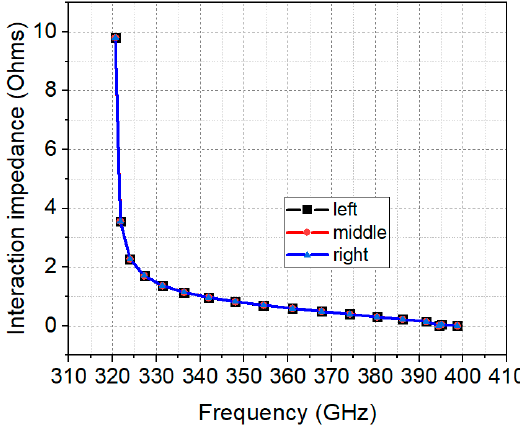
Figure 4. Interaction impedance of three tunnels for mode 3.